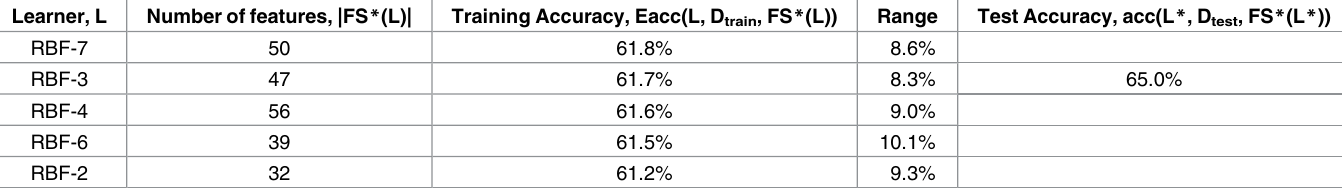
Table 13. ABIDE, personal characteristic data with functional images.